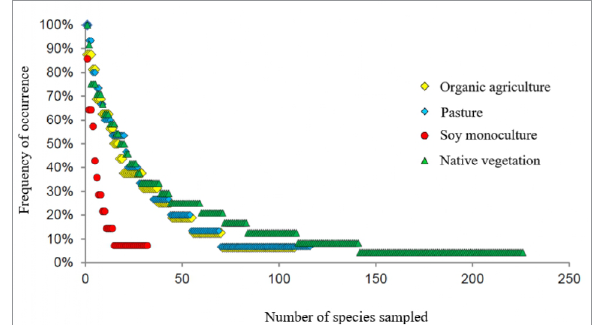
Figure 4: Estimated number of ant species by number of sampled locations using the Jack1 estimation with the respective standard deviation based on collections made between June 2019 and August 2020 in the Rashad District.